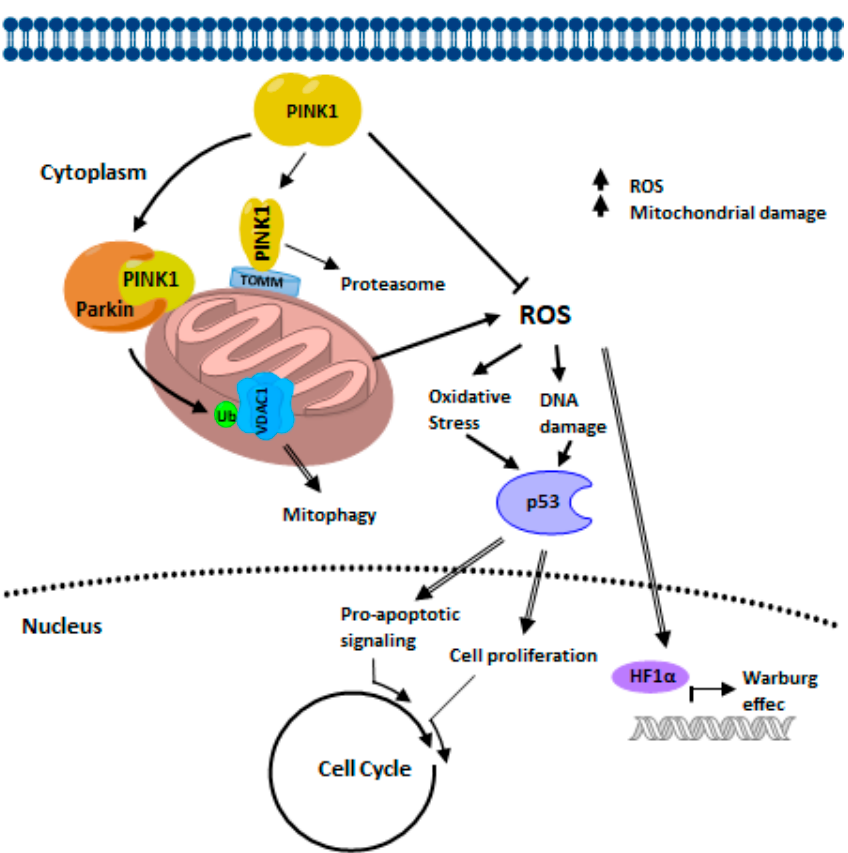
Figure 2. Graphical representation of the interactions of the PINK proteins. The directionality and the nature of the interactions (activation or inhibition) are shown as they are believed to exist in a healthy state.